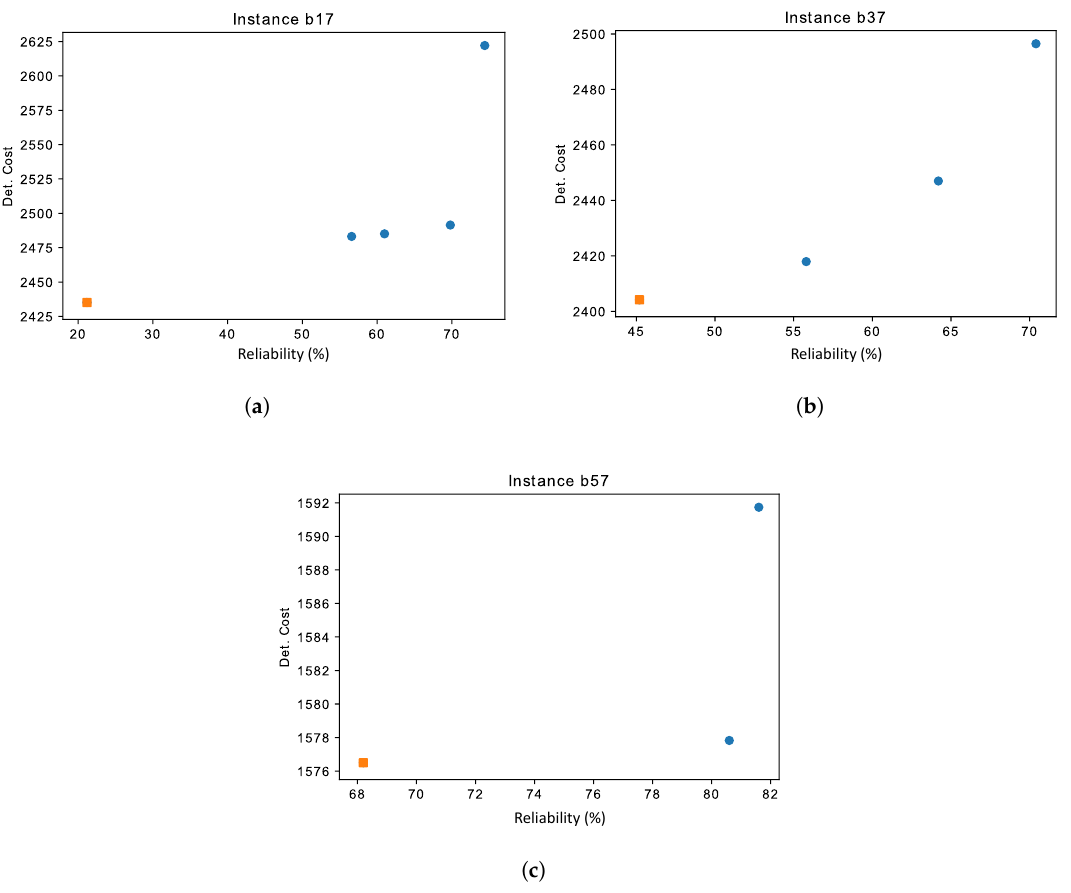
Figure 7. Set of non-dominated solutions of problem instances b 17 ( a ), b 37 ( b ) and b 57 ( c ). ( a ) Non-dominated solutions for problem instance b 17 (tight inventory). ( b ) Non-dominated solutions for problem instance b 37 (relaxed inventory). ( c ) Non-dominated solutions for problem instance b 57 (abundant